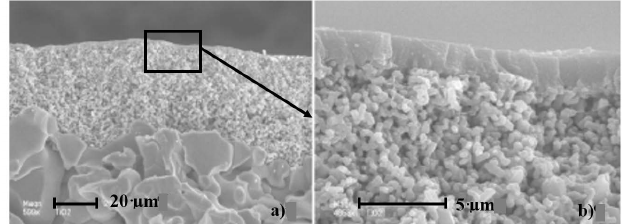
Figure 1. SEM images of the cross-section of a TiO 2 membrane at different enlargements. ( a ) magnification of 500 × , macroporous alumina at the bottom, mesoporous alumina in the middle and TiO 2 layer at the top; ( b ) Zoom of the selected area at a magnification of 4600 × , thin layer of TiO 2 at the top and mesoporous alumina just below.